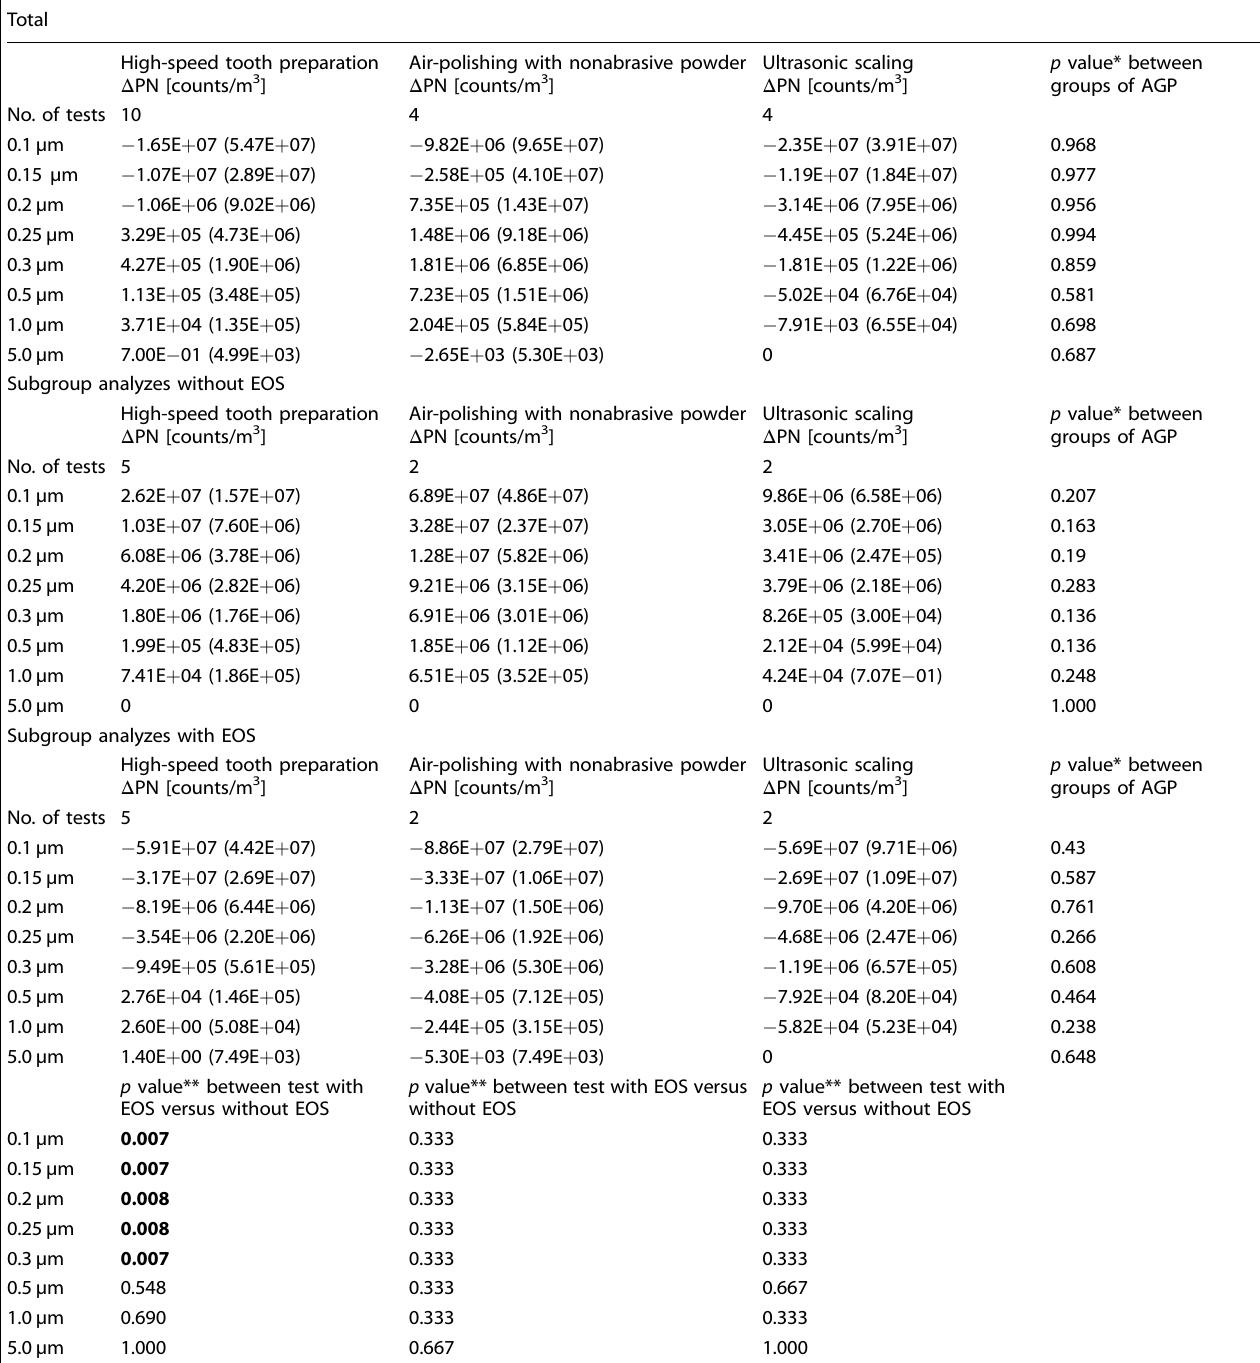
Table 2. Subgroup results of the change in particle number concentration (mean(SD) Δ PN: counts/m 3 ) for eight categories of particles between 0.1 and 5.0 µm for all aerosol-generating procedures (AGP: high-speed tooth preparation; air-polishing with nonabrasive powder; supra-/subgingival scaling with an ultrasonic scaler) with and without a mobile extraoral scavengers (EOS)